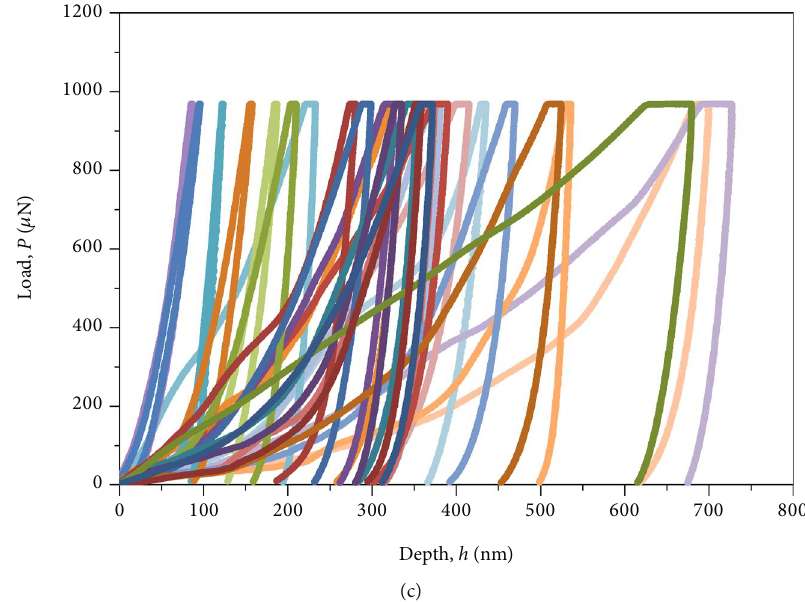
Figure 8: Typical load-depth curves of mudstone specimens obtained from nanoindentation: (a) NM-1, (b) NM-2, and (c)